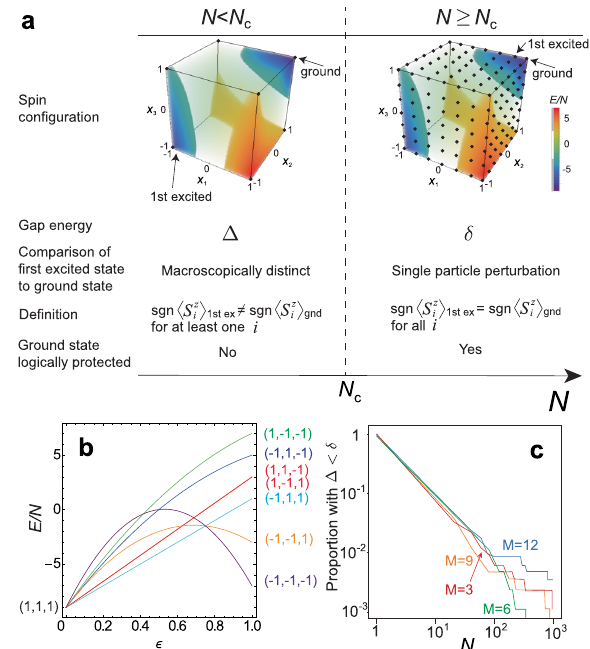
Fig. 1 Properties of the problem Hamiltonian H Z . a Summary of the two regimes for the ensemble version of the problem Hamiltonian H Z . The cube shows the energy landscape of a typical i = N . Dots indicate instance of Eq. (4) with rescaled variables x i ¼ h S z i allowed states for N = 1 (left) and N = 6 (right). Only states on the visible faces are shown for clarity. b Energy variation for the problem instance as Fig. 1a along a linear trajectory from the ground state x 1 = x 2 = x 3 = 1 to other hypercube corners speci fi ed by ð x ð f Þ ; x ð f Þ ; x ð f Þ Þ . The trajectory is de fi ned by x ¼ 1 (cid:2) ð 1 (cid:2) x ð f Þ Þ ε , where i 1 2 3 i ε = 0 is the ground state and ε = 1 is another hypercube corner. Parameters used are M = 3, J 12 = − 2, J 13 = − 1, J 23 = − 1, K 1 = 1, K 2 = 0, K 3 = − 2. c Proportion of 800 randomly generated problem instances with Δ < δ (i.e., N < N c ) as a function of the ensemble size N . Elements of J ij and K i are taken randomly in the interval (cid:2) 1 ; 1 ½ with a uniform